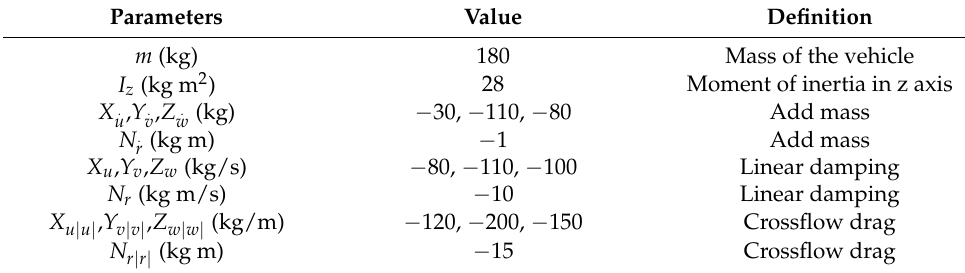
Table 3. The link parameters of the manipulator.